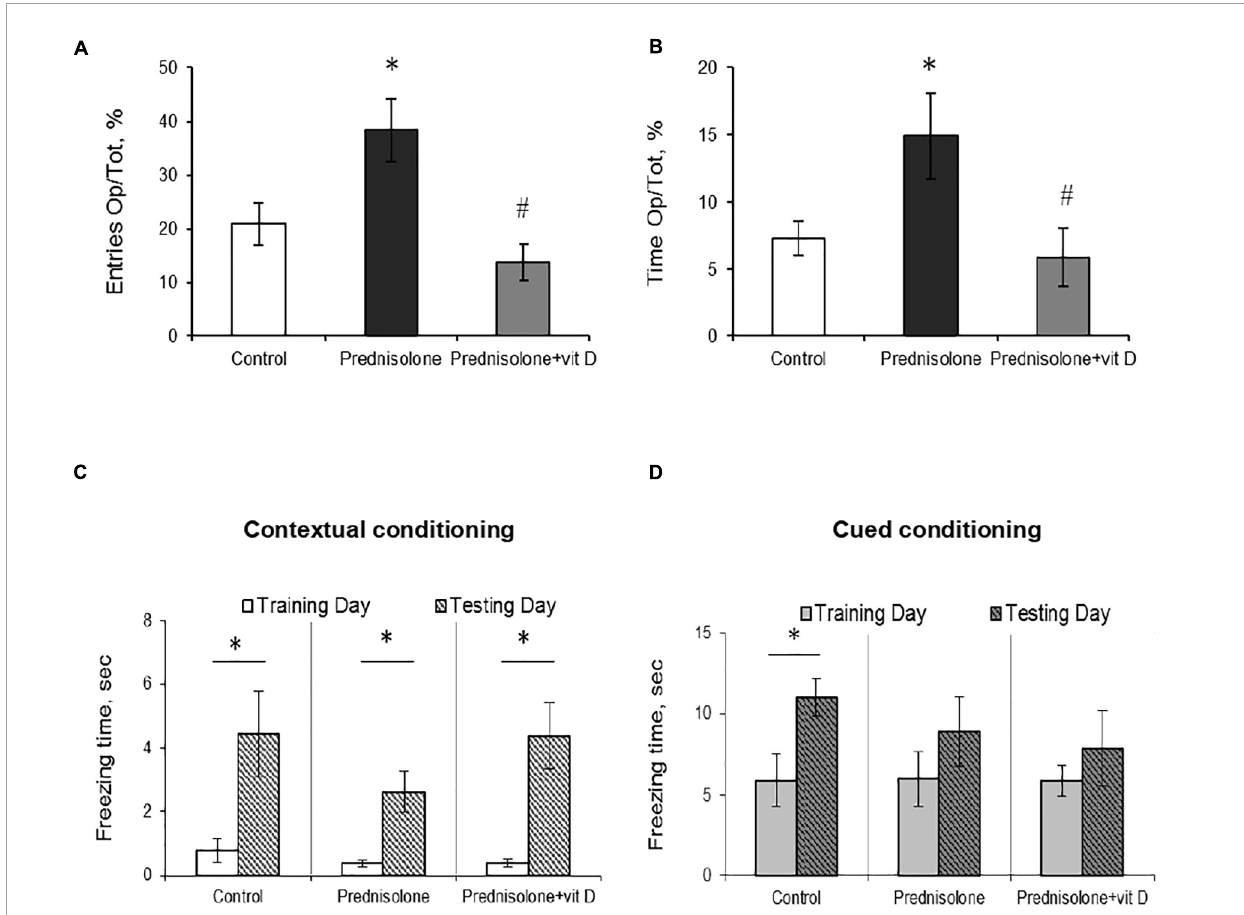
FIGURE4 The effect of prednisolone and vitamin D 3 on the behavior in the elevated plus maze (EPM) and contextual and cued fear conditioning and memory test. Animals from three experimental groups: 1—control; 2—prednisolone administration; 3—prednisolone and vitamin D 3 administration ( n = 8 rats/group) were subjected to the EPM (A,B) and contextual/cued conditioning test (C,D) . The percentage of entries into the open arms to the total time (Op/Tot) (A) and the ratio of time spent in the open arms to the total time (Op/Tot) (B) were measured during the EPM. Mean freezing time levels during the contextual (C) and cued (D) conditioning test were assessed after prednisolone and vitamin D 3 treatment during training and testing days. All data are presented as mean ± SD of three independent experiments done in triplicate; ∗ p < 0.05 denotes significance compared with control, # p < 0.05 denotes significance compared with prednisolone